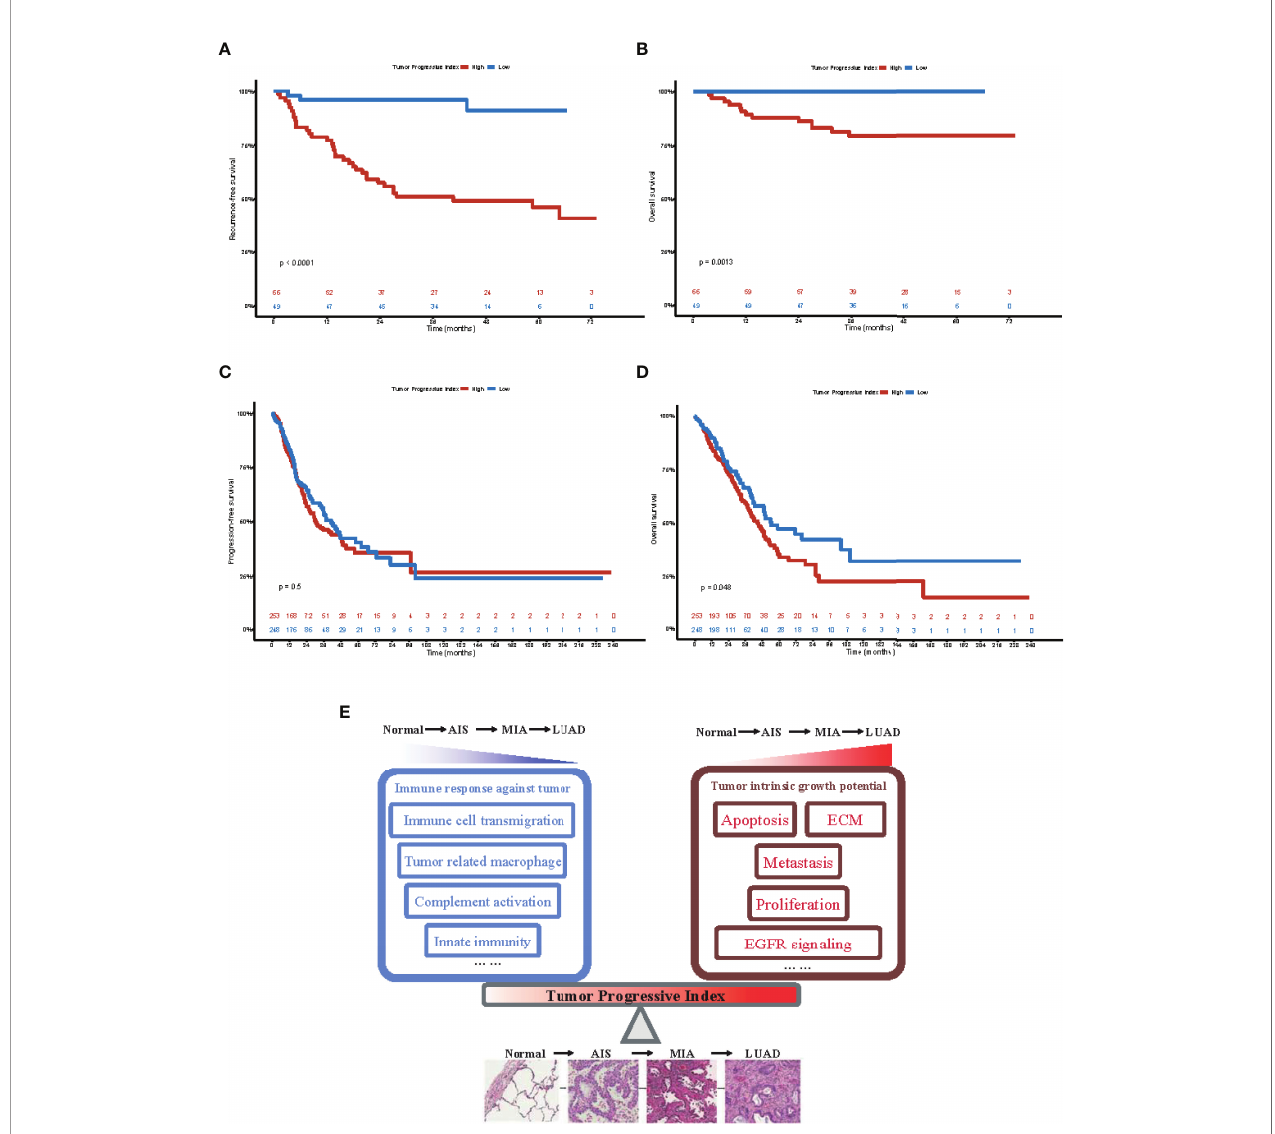
FIGURE 6 | Prognostic value of tumor progressive index for patients with lung adenocarcinoma. (A) Recurrence-free survival for patients with tumor progressive index higher and lower than the median value across the Fudan University Shanghai Cancer Center (FUSCC) cohort. (B) Overall survival for patients with tumor progressive index higher and lower than the median value across the Fudan University Shanghai Cancer Center (FUSCC) cohort. (C) Recurrence-free survival for patients with tumor progressive index higher and lower than the median value across the TCGA-LUAD cohort. (D) Overall survival for patients with tumor progressive index higher and lower than the median value across the TCGA-LUAD cohort. (E) Schematic demonstration showing the imbalance between tumor intrinsic growth potential and immune response against tumor, which can be measured by tumor progressive index, leads to the evolution and progression of lung